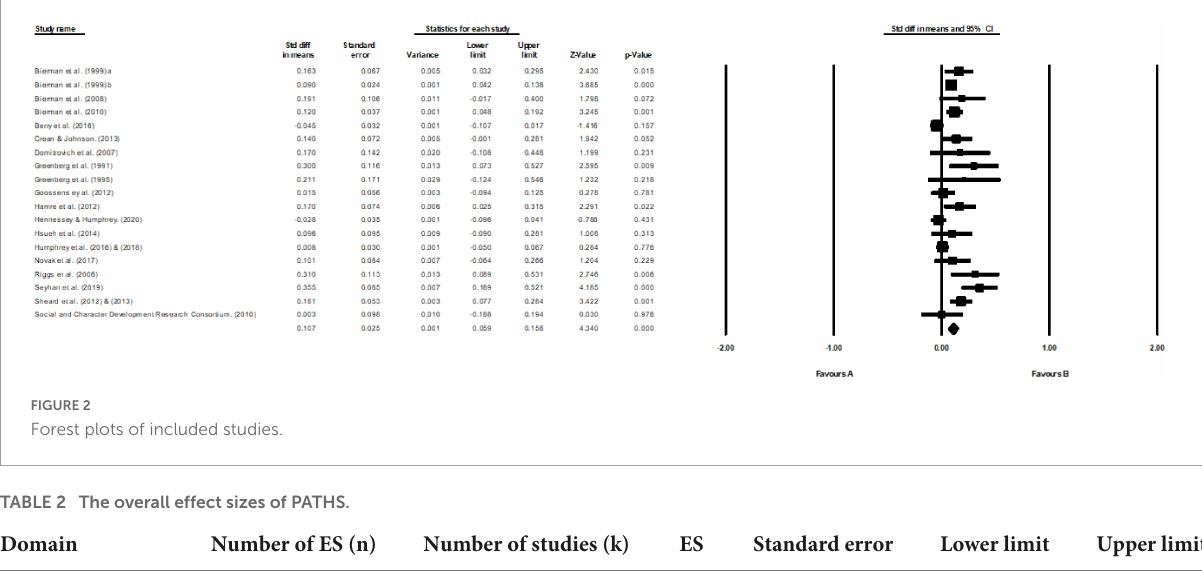
TABLE 2 The overall effect sizes of